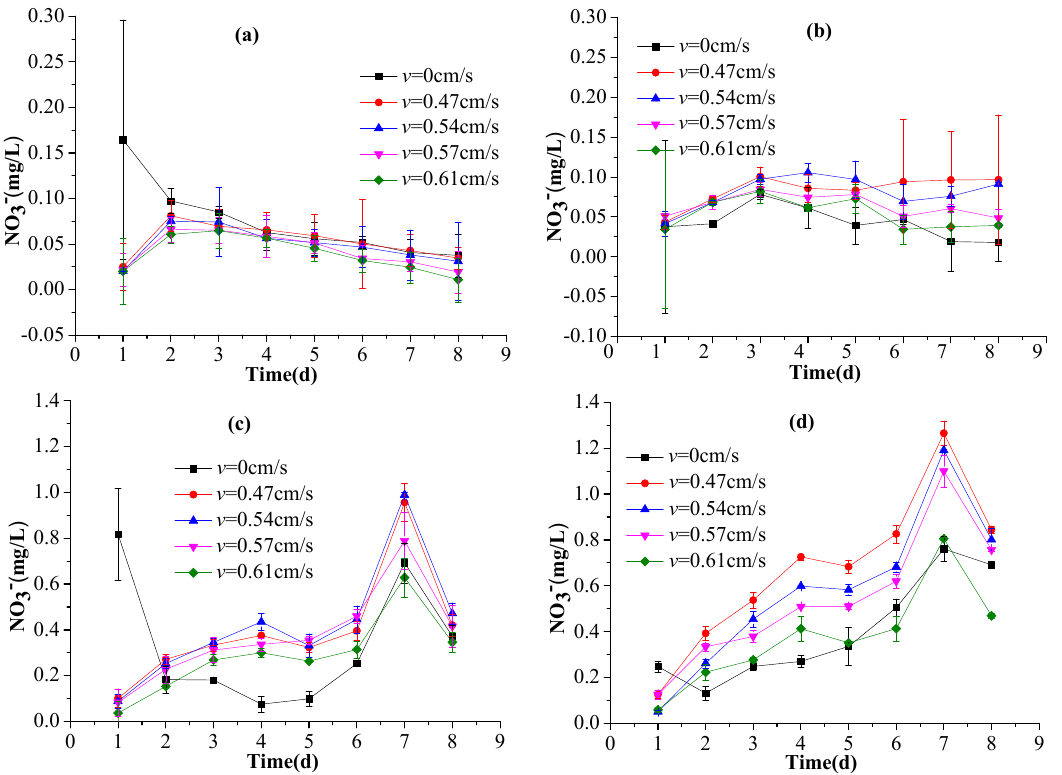
Figure 8. Nitrate (NO 3 ‐ N) concentrations at depths of: ( a ) 6 cm; ( b ) 3 cm; and ( c ) 1 cm within the sediments; and ( d ) in the overlying water, during the experiment. Table 2. The regression equations for theNO 3 ‐ N concentrations.